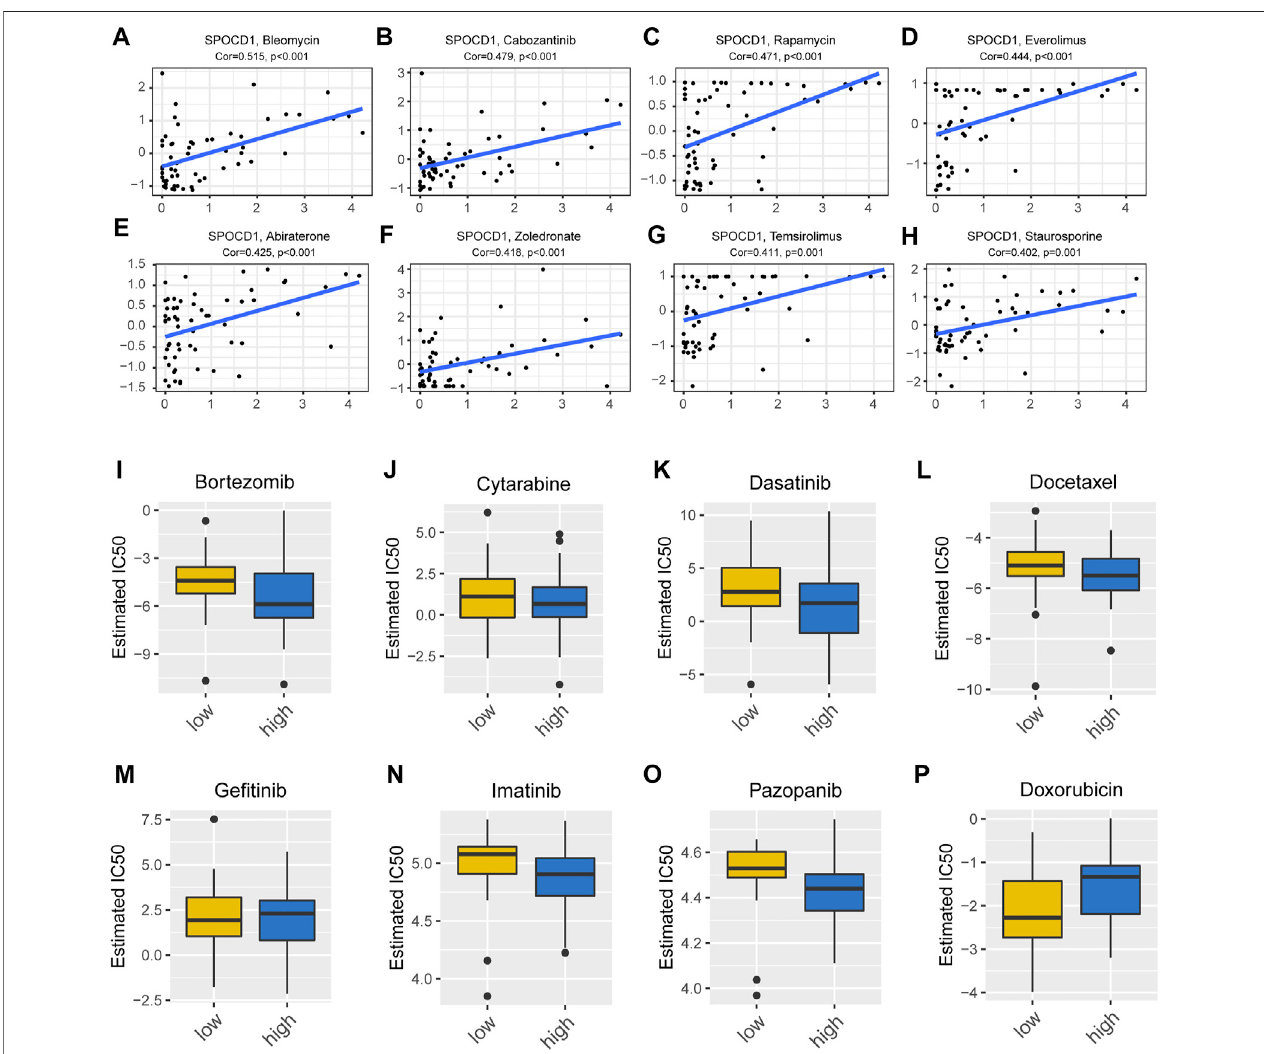
FIGURE5| Drugsensitivityanalysisand drugprediction. (A – H) Thetopeightdrugswiththemostsigni fi cantcorrelation withSPOCD1inCellMiner database; (I – P) The differences in IC50 values for drugs prediction with high and low SPOCD1 expression from the GDSC database. SPOCD1, SPOC Domain Containing 1; GDSC, genomics of drug sensitivity in